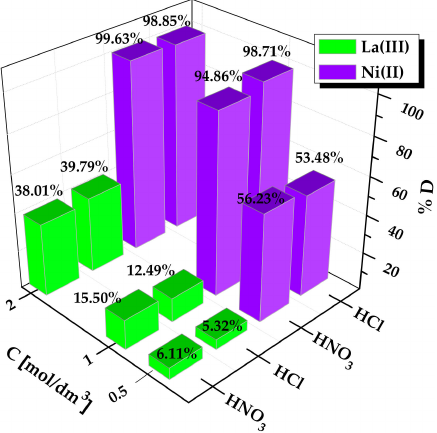
Figure 7. Regeneration e ffi ciency of La(III) and Ni(II) ions on Lewatit Monoplus